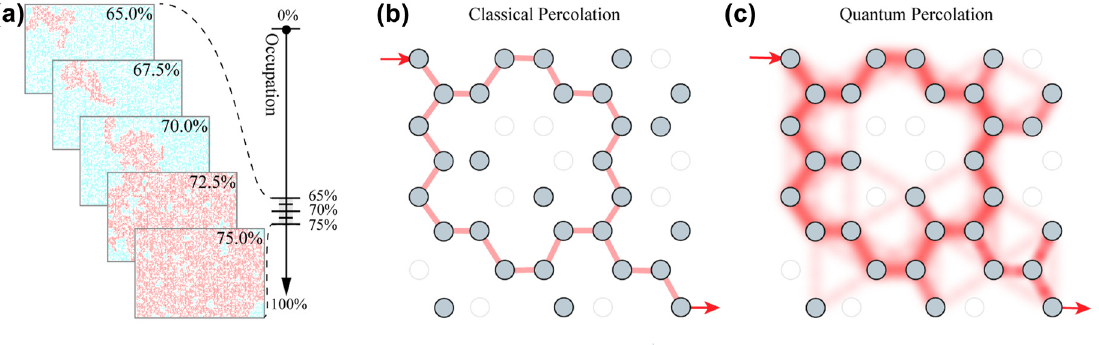
Figure 1: Classical and quantum percolation. (a) Classical percolation is simulated in a hexagonal lattice and the largest cluster is denoted in red. (b–c) A classical particle (no coherence) is injected into the percolation lattice where gray sites are occupied and white ones are empty. A percolation completes when the particle penetrates the lattice and arrives at the other end. In classical percolation (b), an infinite path spanning across the graph means a complete percolation, while in quantum percolation (c), photon can interfere with itself through all possible paths, and can access classically forbidden paths by